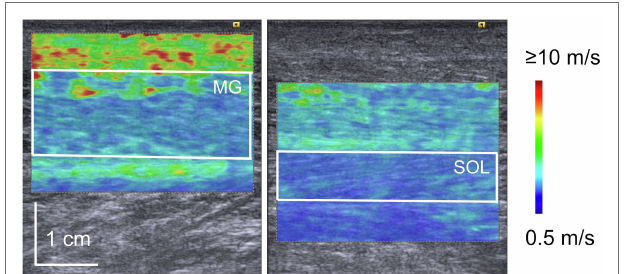
of interest for shear wave elastography. Blue color indicates the lower speed of shear wave propagation while red indicates the higher speed of shear wave